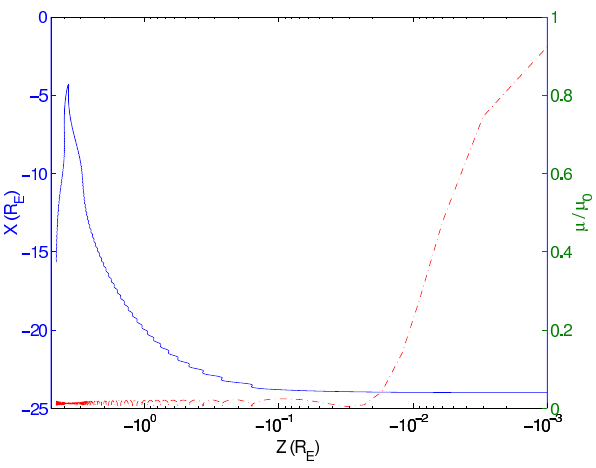
Fig. 16. The trajectory of a particle in the X − Z plane is shown (left ordinate, solid line) as a reference against which to compare the variation of the magnetic moment ( µ ) which is the dashed-dot line and right ordinate. The magnetic moment is nor- malised. The particle comes from the model boundary in the Southern Hemisphere, and arrives at the observation location at (X,Z) = ( − 24 , 0 . 0001 ) R E with a velocity ( V B ,V C ,V E ) = ( 500 , − 1060 , 0 )